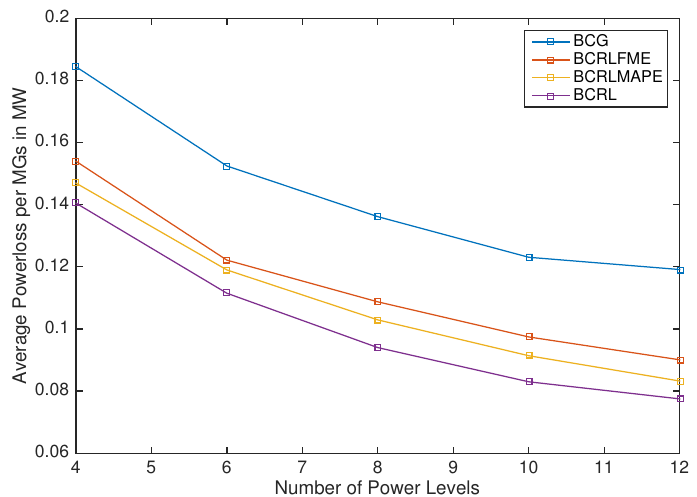
Figure 5. Average power loss per microgrid versus the number of power